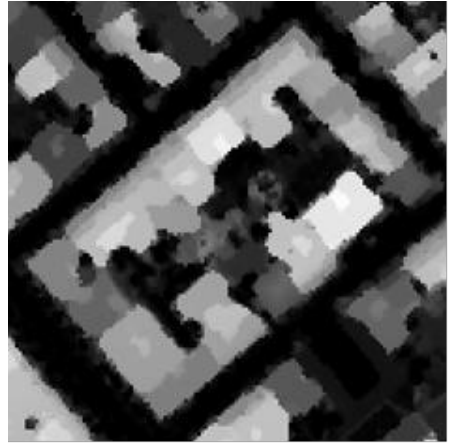
Fig. 5 Test area with Buildings manually identified